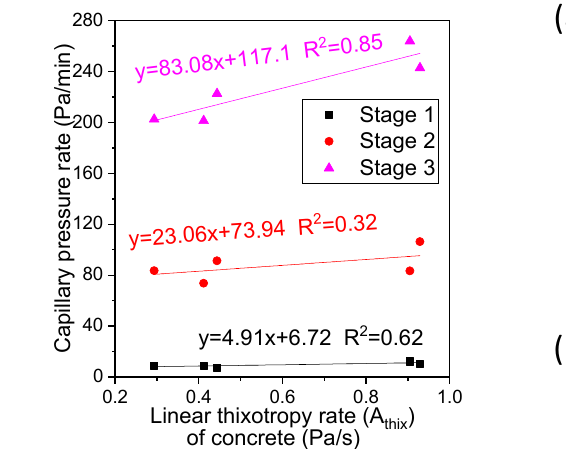
Figure 13. Relationship between the rate of capillary pressure build ‐ up and rate of structuration.